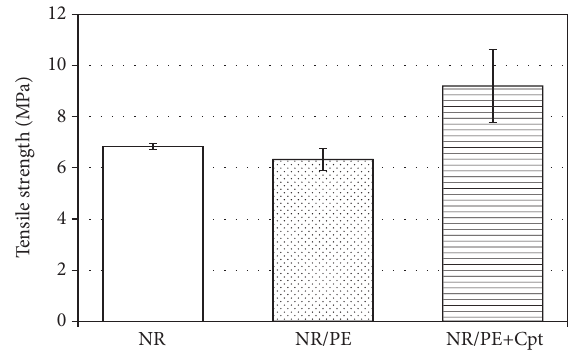
Figure 4: Tensile strength of neat NR, NR/PE blend, and NR/PE blend treated with compatibilizer.